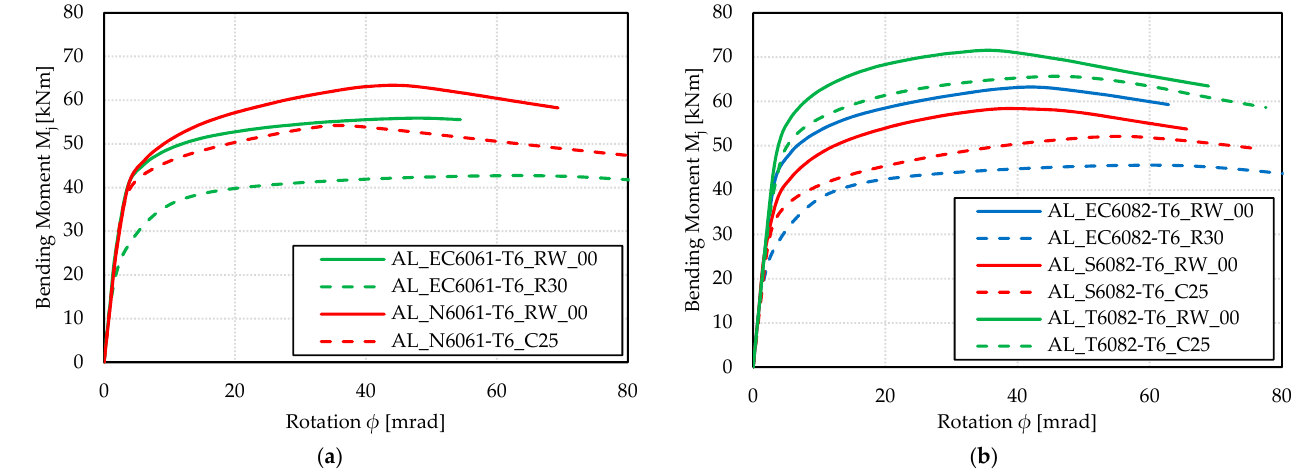
Figure 14. Moment–rotation curves for models with the effect of reduced mechanical properties in the HAZ for alloys: ( a ) EN AW-6061-T6; ( b ) EN AW-6082-T6.